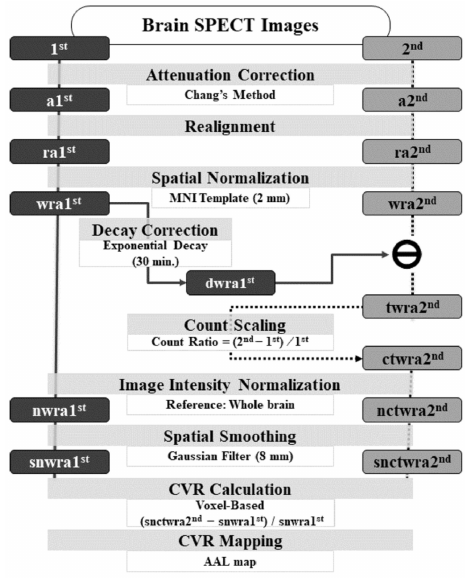
Figure 2. Diagram representing SPECT cerebrovascular reactivity (CVR) processing using the first and second SPECT